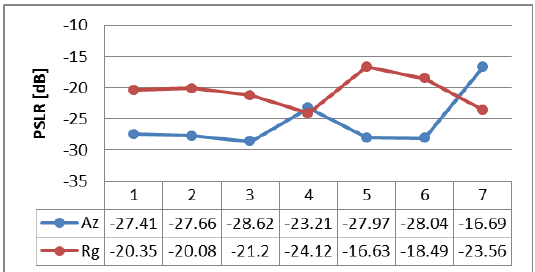
Figure 19. KOMPSAT-5 SAR PLSR assessment